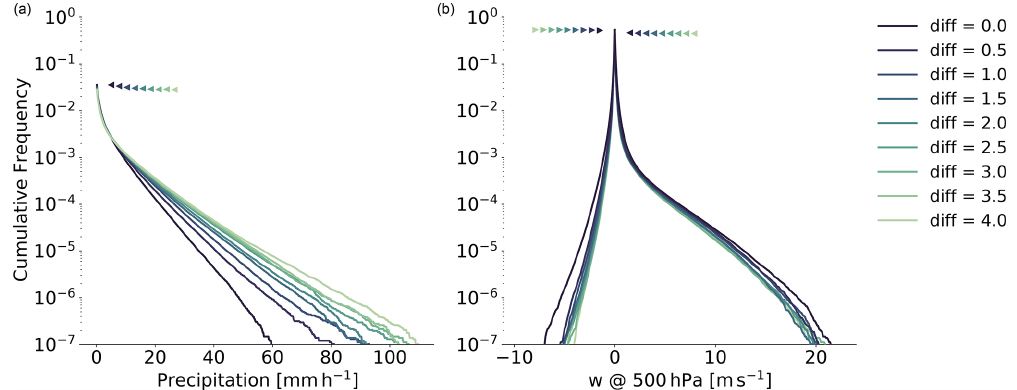
Figure 9. Cumulative frequency of hourly precipitation (a) and vertical wind speed at 500hPa (b) for runs with COSMO 2.2km and different values for explicit horizontal diffusion of wind, temperature, pressure, and moisture